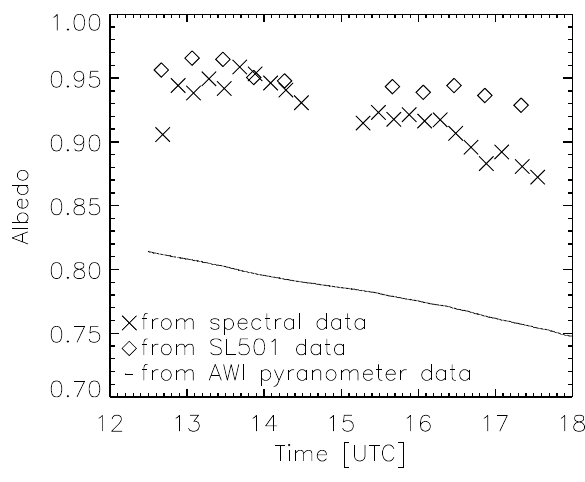
Fig. 7. Diurnal cycle of mean albedo on 4 January 2004 derived from different radiation sensors. For the period shown, the sky was cloud free. All sensors show a decrease in albedo the later in the day it became, thus the larger the solar zenith